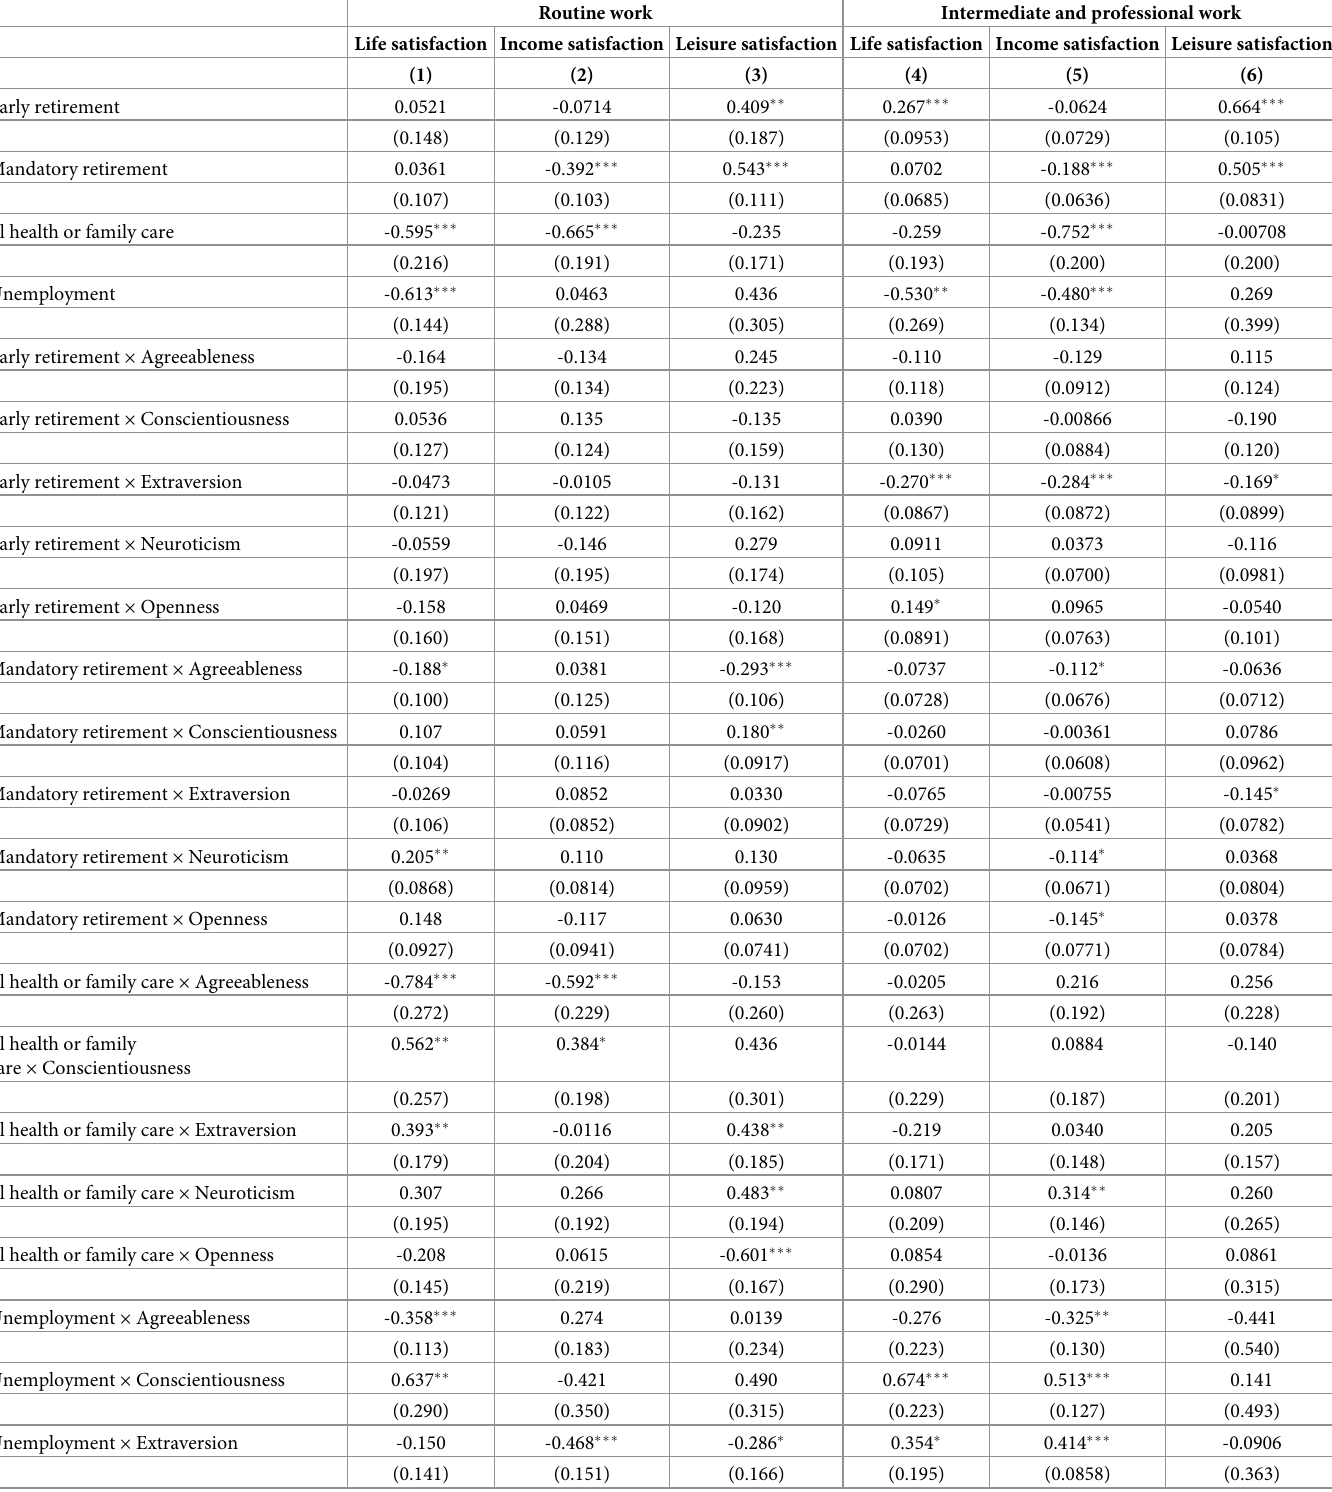
Table 4. Exit pathways, personality traits and well-being by the last job type.